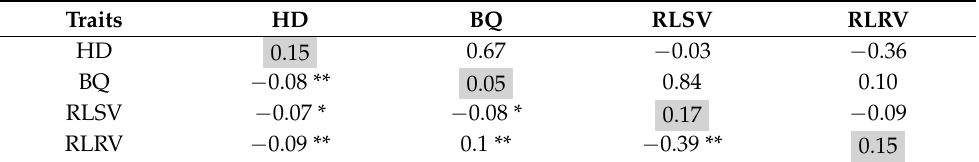
Table 2. Genetic (upper diagonal), Pearson phenotypic (lower diagonal) correlations and heritability (grey diagonal line) for feet and leg traits measurements.